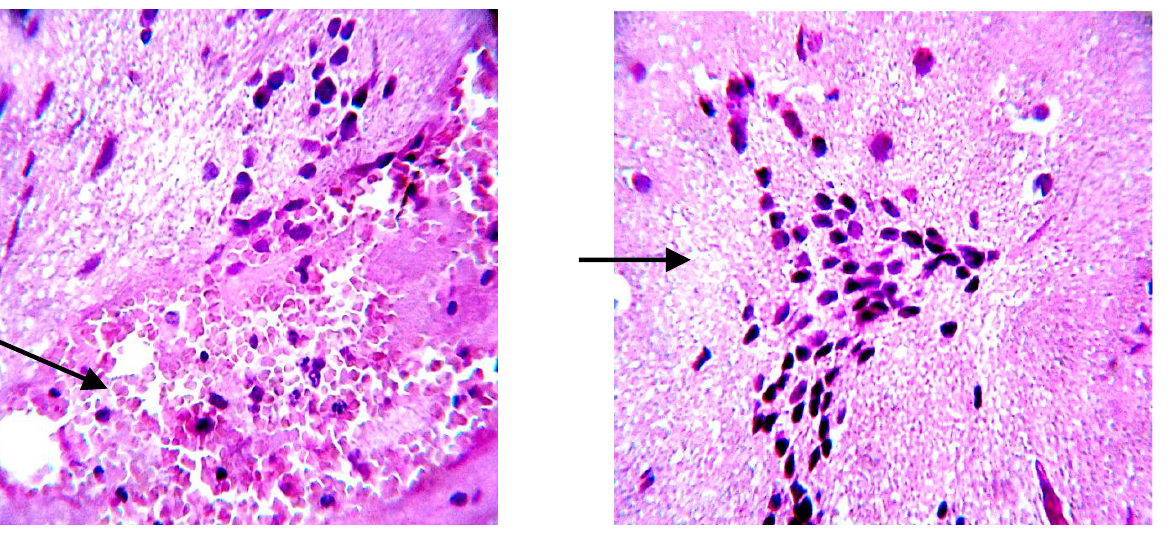
Fig:11, Histopathological section in Brain,T2, Fig:12,Brain, T2,show microgliasis characterized show hemorrhage in the brain tissue with by aggregation of microglia cell with elongated aggregation of microglia (H & E stain. 40 X) nuclei in the cerebellum (H &E stain stain. 40 X)